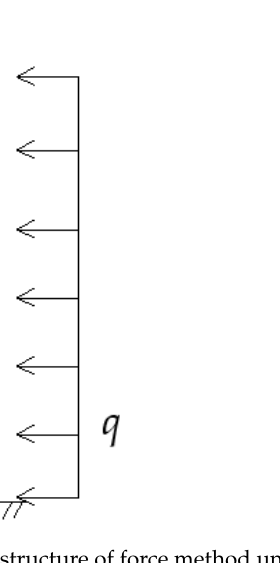
8 of 23 Figure 8. Simplified calculation model of wall column.